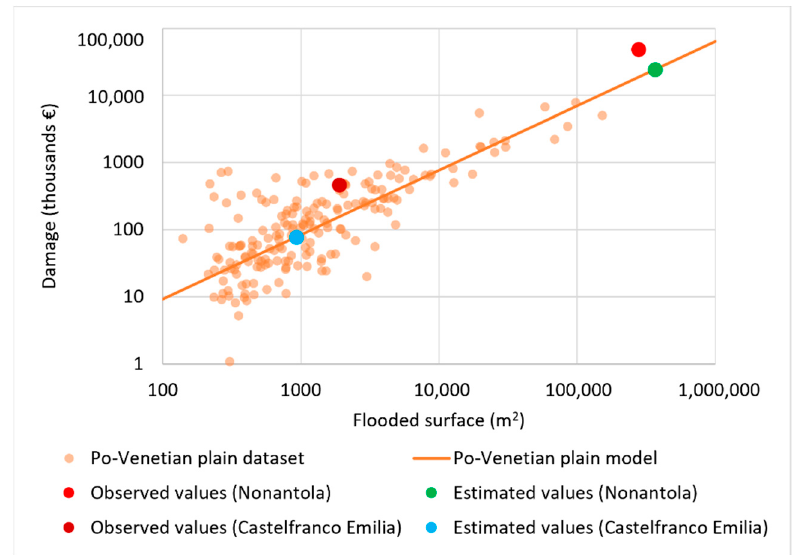
Figure 13. Comparison between observed and estimated damages for the study case.